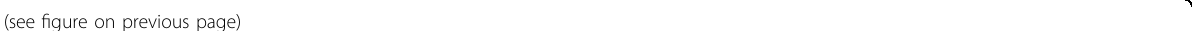
Fig. 1 LSD1 is enriched at the cell surface and in intracellular compartments of ACE2-expressing cells. a The receptor-binding domain (RBD) sequence of SARS-CoV-2 showing the critical residue (Q; glutamine 493) that binds to ACE2 lysine 31 and the conservation of this sequence in different species. In silico prediction 35 gave a probability of 0.7 of a methylation/demethylation signature at lysine 31. b FACS tSNE analysis of cell surface and intracellular expression of ACE2 and LSD1 in Caco-2 cells. The bar chart indicates the percentage ACE2 + or LSD1 + cells in the total Caco-2 population, also shown in the FACS dot plots (ACE2 + cells in blue and LSD1 + cells in red). Data are mean ± SEM ( n = 3). c Western blot analysis of ACE2 and LSD1 cell surface expression by Caco-2 cells. Membrane lysates were analyzed by SDS-PAGE and blotted for ACE2, LSD1, and integrin- β 1. d Western blot analysis of LSD1 IP samples. Following LSD1 IP of Caco-2 lysates, samples were analyzed by SDS-PAGE and blotted for CoREST (66kD) and HDAC2 (60kD). e Dot plot quanti fi cation of the fl uorescence intensity (cell surface and cytoplasmic) of ACE2 and LSD1 in Caco-2 and MRC-5 cells. >50 cells were analyzed for each group. The Pearson correlation coef fi cient (PCC) was calculated for LSD1 and ACE2 colocalization ( n = 20 cells analyzed). Mann-Whitney test: ∗ P < 0.05, ∗∗∗∗ P < 0.0001 denote signi fi cant differences. f Duolink ® proximity ligation assay measurements of protein interactions were performed on unpermeabilized Caco-2 cells transfected with either VO construct or an LSD1 WT plasmid followed by treatment with 0, 1, or 10 ng of SARS-CoV-2 spike protein. The Duolink assay produces a single bright dot per interaction within the cell. Representative images (top) are shown for ACE2 and SARS-CoV-2 Spike Duolink ® . PLA signal intensity of the Duolink ® assay (bottom) is shown for average dot intensity (single Duolink dot). Data represents n = 20 cells, with signi fi cant differences calculated using the Kruskal-Wallis ANOVA ( ∗ P < 0.05, ∗∗ P < 0.01, ∗∗∗∗ P < 0.0001). Representative images are shown with 10 µM scale bar in orange. g Schematic of SARS-CoV-2 infection assays. Caco-2 cells were seeded 24 h before the experiment. Then, cells were infected with SARS-CoV-2 (MOI 1.0). After 1 h viral adsorption incubation, the virus inoculum was removed and drug-free medium was added. Then, cell culture supernatants were harvested at 0, 24, 48, or 72 hpi (hour post-infection) and infected cells collected at 24, 48, or 72 hpi. Viral genomes were detected in the extracted RNA by qRT-PCR, and viral protein was quanti fi ed by digital pathology (ASI system). h qRT-PCR analysis to detect the growth kinetics of SARS-CoV-2 in Caco-2 and MRC-5 culture supernatants at the indicated time points after viral infection. The quantity of viral genomes is expressed as log10 TCID 50 equivalents/mL. Data are mean ± SEM ( n = 3). One-way ANOVA; ∗ P < 0.05, ∗∗ P < 0.01 denote signi fi cant differences. i FACS analysis of expression of SARS-CoV-2 N (nucleocapsid), ACE2, and LSD1 in uninfected vs. SARS- CoV-2-infected Caco-2 cells ( n = 3, unpaired t -test: ∗∗∗ P < 0.001). j Dot plot quanti fi cation of the fl uorescence intensity (cell surface and cytoplasmic) of ACE2 and LSD1 in uninfected or SARS-CoV-2-infected CaCo-2 and MRC-5 cells. >50 cells were analyzed for each group. Mann – Whitney test: n.s. denotes non-signi fi cant, ∗∗∗ P < 0.001, ∗∗∗∗ P < 0.0001. The PCC was calculated to assess colocalization in MRC-5 or Caco-2 cells with/without infection ( n = 20 cells analyzed). Data are mean ± SEM. Mann-Whitney test: n.s. denotes non-signi fi cant, ∗∗∗∗ P < 0.0001 denote signi fi cant differences. k Representative image of uninfected or SARS-CoV-2-infected Caco-2 cells using the Andor WD Revolution Inverted Spinning Disk microscopy system. Cells were not permeabilized (surface), with immunostaining for ACE2, LSD1, and SARS-CoV-2 N (nucleocapsid). DAPI (blue) was used to visualize nuclei. Scale bar, 12 μ m (inset). l Dot plot quanti fi cation of the fl uorescence intensity of H3K9me2 and H3K4me2 in uninfected or SARS-CoV- 2-infected Caco-2 cells. >50 cells were analyzed for each group. Mann – Whitney test: ∗∗∗∗ P < 0.0001 denote signi fi cant differences. m Dot plot quanti fi cation of the fl uorescence intensity (cell surface and intracellular) of SETDB1, G9A, and ACE2 in uninfected or SARS-CoV-2-infected Caco-2 cells. >50 cells were analyzed for each group. Mann-Whitney-test: n.s. denotes non-signi fi cant, ∗∗∗ P < 0.001, ∗∗∗∗ P < 0.0001 denote signi fi cant differences. n Representative image of uninfected or SARS-CoV-2 infected human biliary epithelial cells (HBECs) using the ASI digital pathology system and immunostaining for α -tubulin, Muc5ac, KRT5, LSD1, ACE2, and SARS-CoV-2 N (nucleocapsid). DAPI (blue) was used to visualize nuclei. Scale bar, 12 μ m (inset). Dot plot quanti fi cation of the mean fl uorescent intensity of α -tubulin, KRT5, and SARS-CoV-2 N (nucleocapsid), and the mean intracellular (cytoplasmic and nuclear combined) fl uorescence intensity of LSD1 in uninfected or SARS-CoV-2-infected cells. n = 3, >20 cells were analyzed for each biological repeat. Mann – Whitney test: ∗∗∗∗ P < 0.0001 denote signi fi cant differences. o Dot plot quanti fi cation of the fl uorescence intensity of ACE2 and LSD1 in KRT5 + SARS-CoV-2 N + cells. The PCC was calculated for LSD1 and ACE2 colocalization. n = 3, >20 cells were analyzed for each biological repeat. p qRT-PCR analysis of LSD1, ACE2 , and TMPRSS2 mRNA expression in uninfected versus SARS-CoV-2-infected HBECs at 48 hpi. Data are mean ± SEM. ( n = 3, unpaired t -test: ** P <